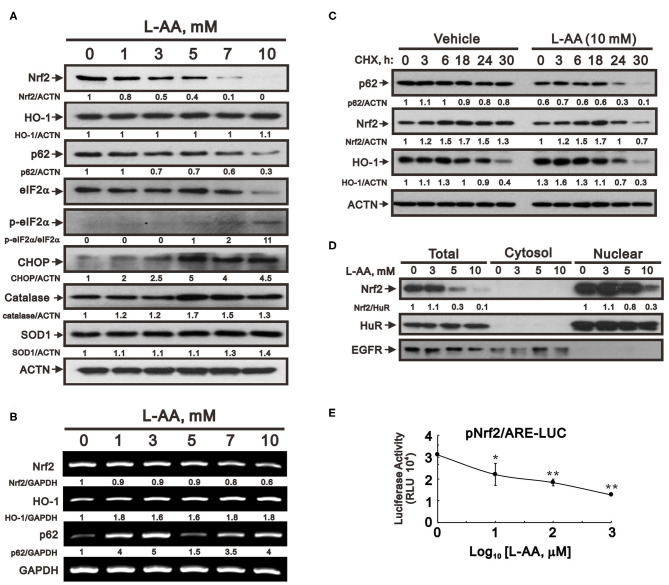
Effect of L-AA on expression of antioxidant proteins in HeLa cells. (A,B) HeLa cells (2 × 105 cells/well) were incubated for 24 h with the indicated concentration of L-AA and then lysed. The cell lysates were subjected to Western blot analysis using antibodies against Nrf2, HO-1, p62, e-IF2α, p-e-IF2α, CHOP, catalase, and SOD1 (A); or to RT-PCR analysis for Nrf2, HO-1, and p62
(B). ACTN was the protein loading control; GAPDH mRNA was the mRNA loading control. (C) HeLa cells (2 × 105 cells/well) were incubated with or without 10 mM L-AA plus 1 μg/ml CHX for the indicated times. Cell lysates were then subjected to Western blot analysis using antibodies against p62, Nrf2, and HO-1. ACTN served as the loading control. (D) HeLa cells (2 × 105 cells/well) were incubated for 24 h with the indicated concentrations of L-AA. Fractionated cell lysates were subjected to Western blot analysis using antibodies against Nrf2, HuR (as a marker of the nuclear fraction), and EGFR (as a marker of the cytosolic fraction). The results (A–D) are representative of three independent experiments. Protein and PCR bands were quantified through pixel density scanning and evaluated using ImageJ, version 1.44a (http://imagej.nih.gov/ij/). The fold was normalized to the internal control protein (ACTN or HuR) or gene (GAPDH). (E) HeLa cells (5 × 104 cells/well) were transiently transfected with 0.5 μg of Nrf2/ARE-LUC reporter and treated with the indicated concentration of L-AA for 24 h. The results are representative of three independent experiments. *p < 0.05 and **p < 0.01 (Student's t-tests).